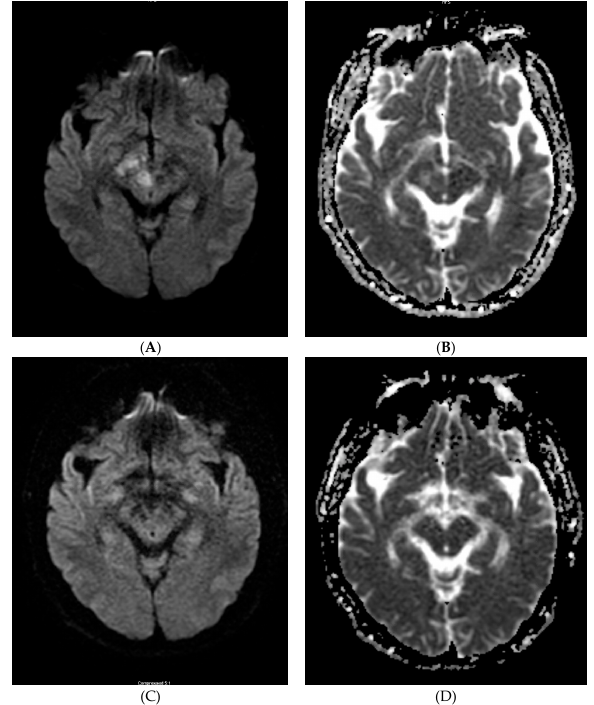
Figure 2. Selected MRI diffusion-weighted imaging (DWI)/apparent diffusion coefficient (ADC) imaging from initial ( A , B from Jan 2017) and last ( C , D from May 2017) MRI.